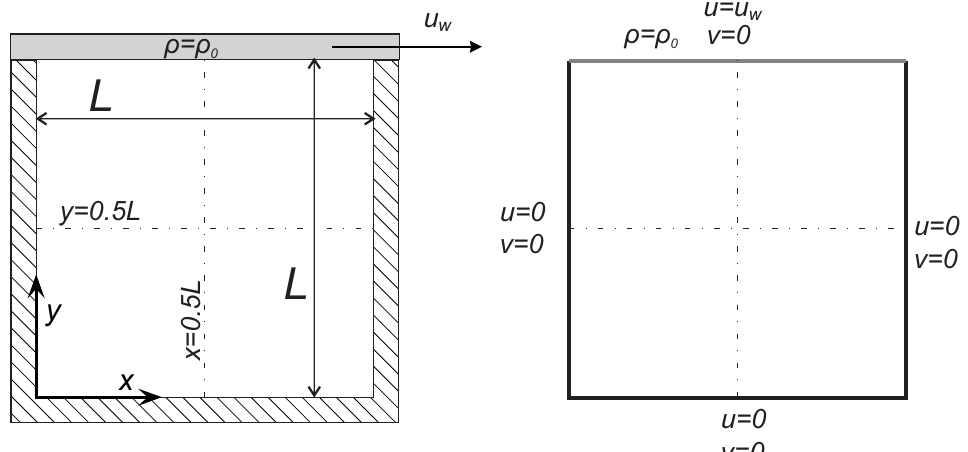
Figure 20. 2D Lid-driven cavity flow: Schematic representation of the geometry and boundary conditions.